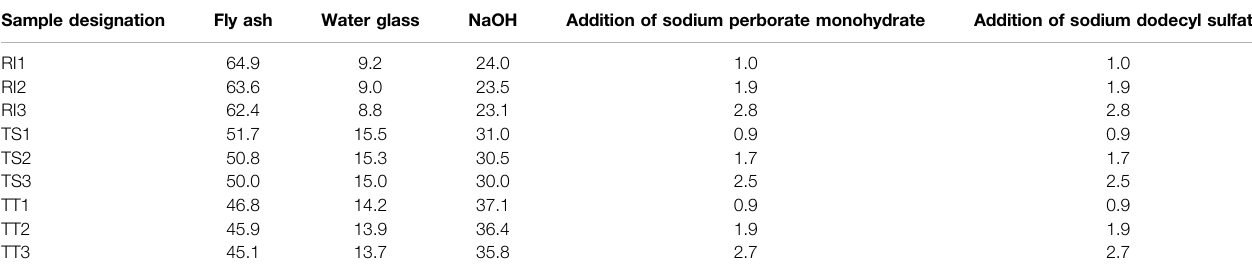
TABLE 2 | The sample designation and sample compositions of the different mixtures prepared for the investigation (in wt%). Sample designation